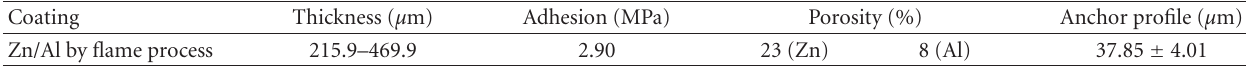
Table 1: Characterization of coating system